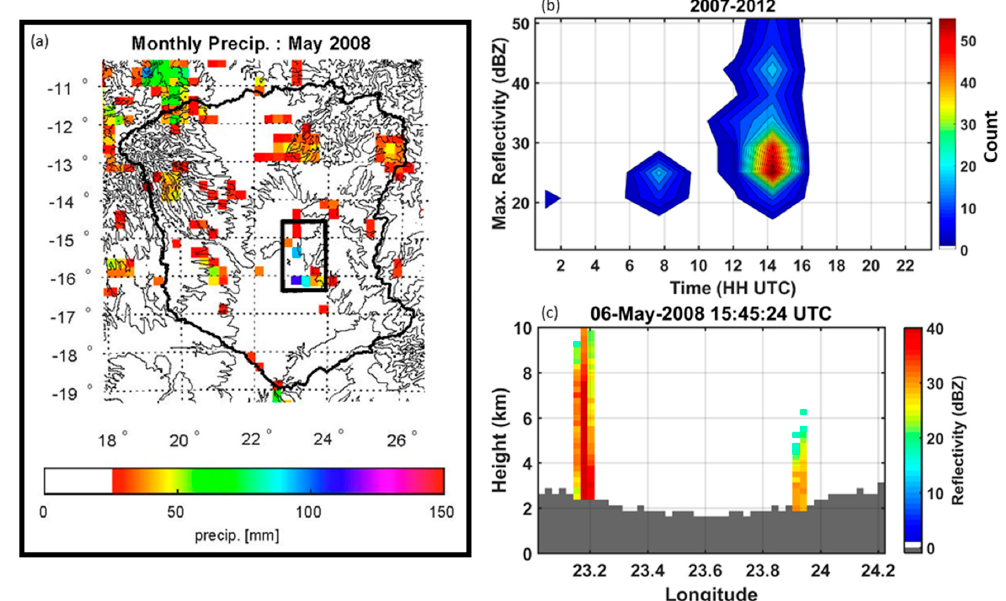
Figure 13. Left panel ( a ): Cumulative monthly rainfall in May 2008 from TRMM 3B42 rainfall product (~25 km resolution). Black box indicates area of interest for land–atmosphere interactions and is the same area shown in Figure S1. Top right panel ( b ): Climatology of the diurnal cycle of rainfall reflectivity from TRMM PR 2A25 product (~5 km resolution) for the month of May. High reflectivity indicates high rainfall rates (i.e., intense storms events). These events only occur between 2007 and 2012. Bottom right panel ( c ): TRMM PR 2A25 reflectivity profiles as examples of isolated deep (early in the transition season) and shallow (daily) isolated convection at around 5:45 p.m. LST on 6 May 2008. The terrain cross-section is marked in dark gray. Remote Sens. 2018 , 10 , x FOR PEER REVIEW